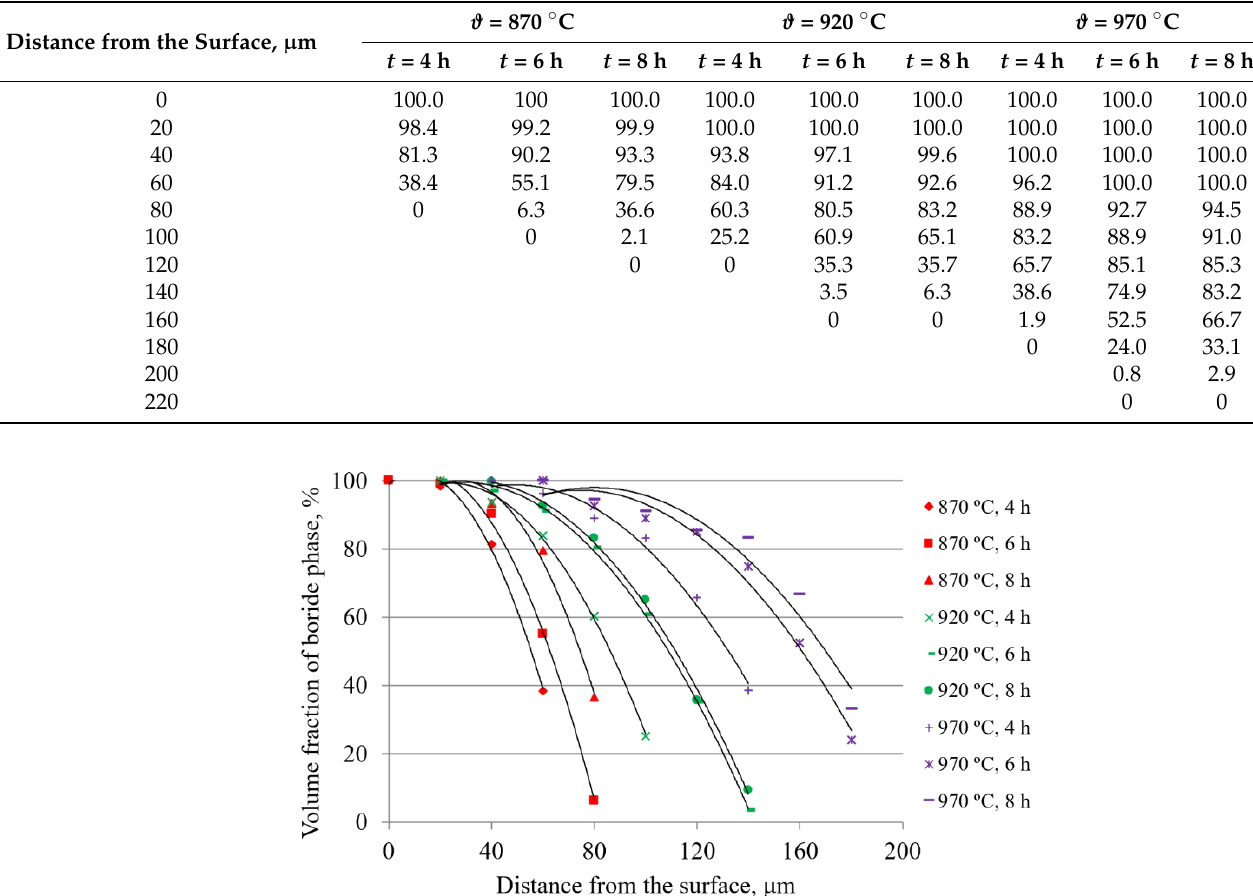
Figure 4. Microstructure of boride layers on C70W2 steel, 200:1 magnification, obtained at: ( a ) 870 °C, 4 h; ( b ) 870 °C, 8 h; ( c ) 920 °C, 4 h; ( d ) 920 °C, 8 h; ( e ) 970 °C, 4 h; ( f ) 970 °C, 8 h. Analysis of the change in the volume fraction of the boride phase in the cross-section was performed on all samples. The results of the analysis are given in Table 2 and the diagram in Figure 5. The obtained results represent the arithmetic mean of the values obtained by measuring three repetitions for each state of the experimental design. Table 2. Volume fraction of the boride phase for steel C70W2, %.